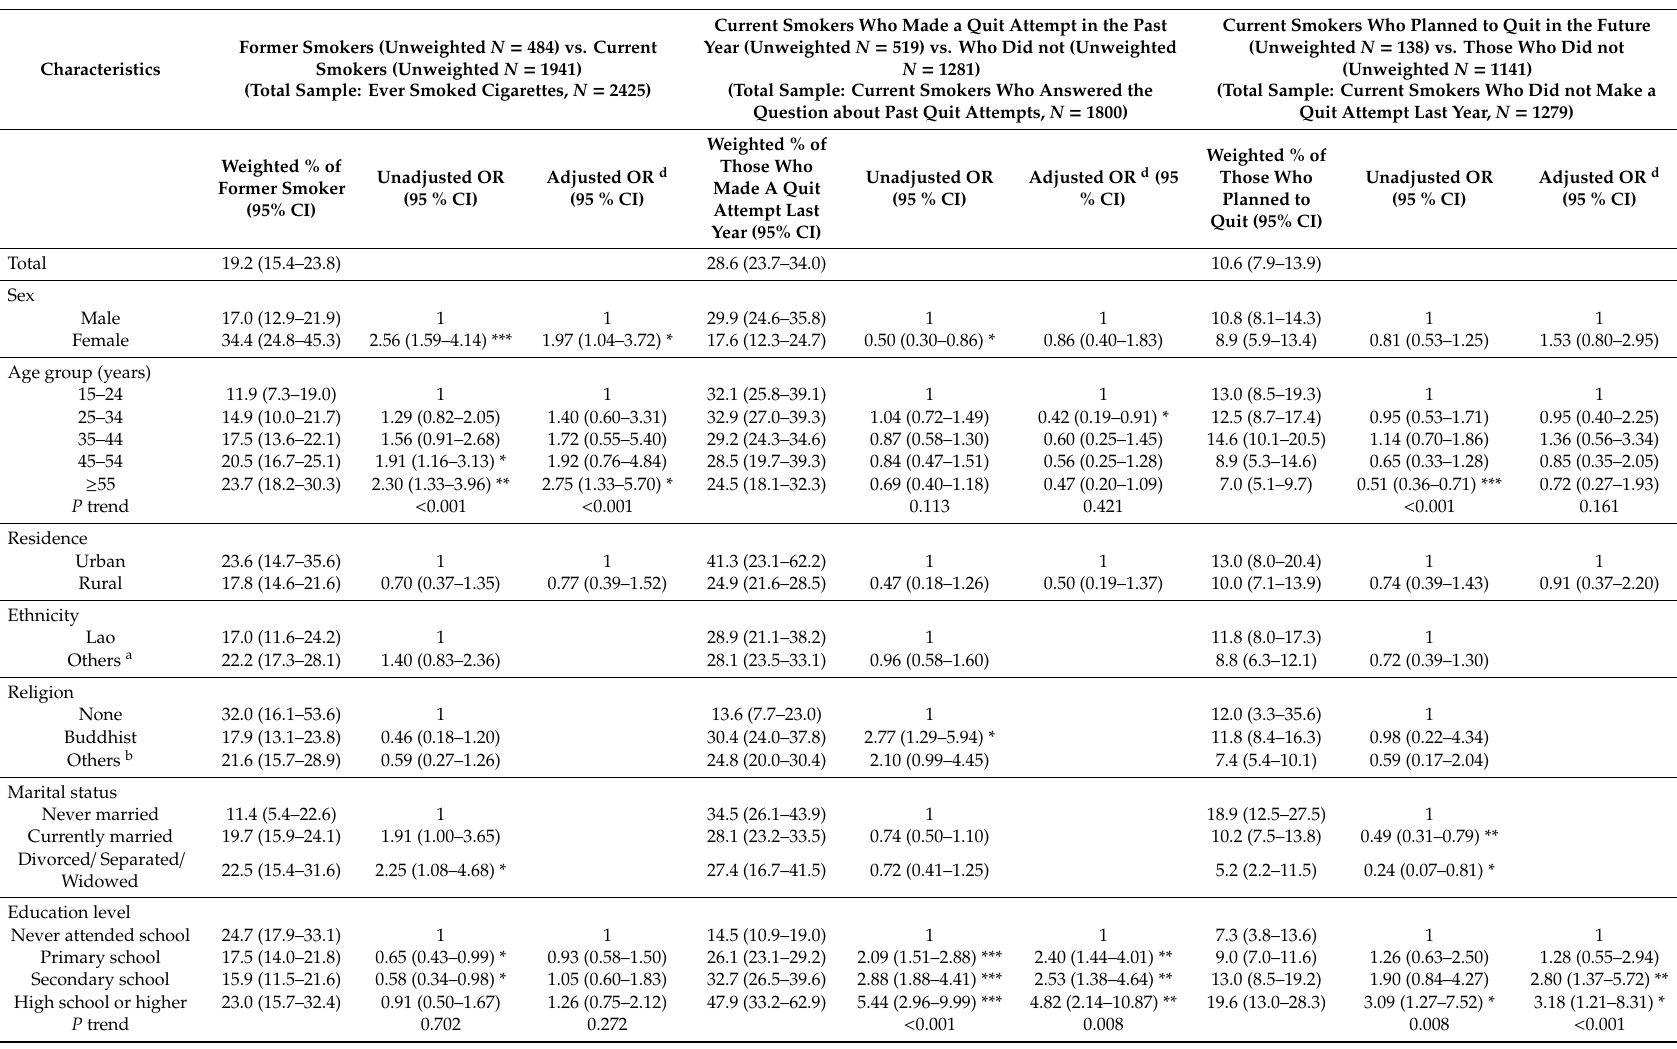
Table 2. Factors associated with smoking cessation and cessation intention among adult cigarette smokers, Lao People’s Democratic Republic, 2015.